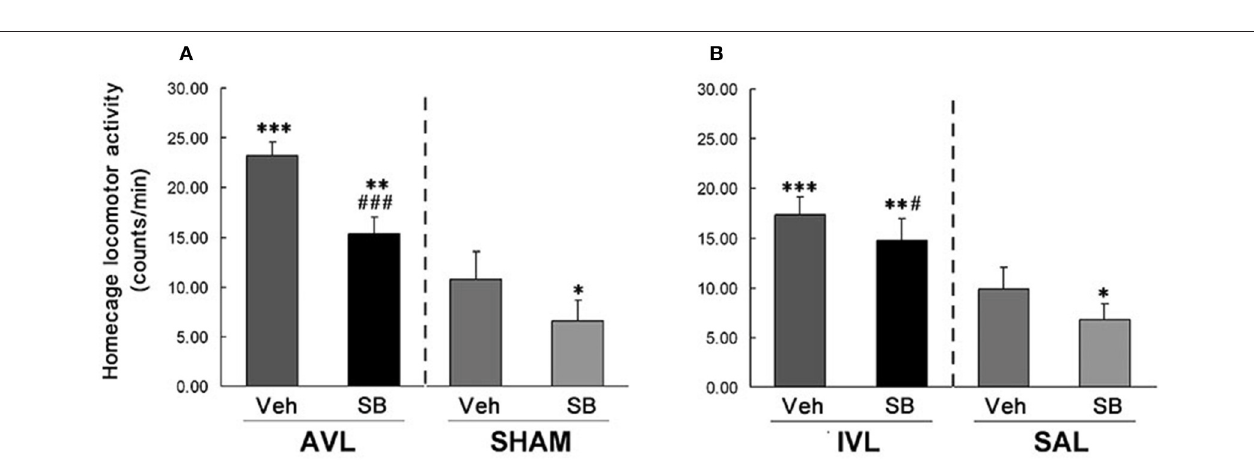
FIGURE 3 | Effects of the orexin receptor type 1 (OX 1 R) antagonist SB334867 on locomotor activity in the home cages after vestibular lesions induced by arsanilate (A) and IDPN (B) in rats. AVL, arsanilate - induced vestibular lesion; SHAM, sham control; IVL, IDPN - induced vestibular lesion; SAL, saline control; Veh, vehicle solution; SB, SB334867. Data are represented as mean ± SEM. * P < 0.05, ** P < 0.01, *** P < 0.001 compared with SHAM or SAL, vehicle control group; # P < 0.05, ### P < 0.001 compared with AVL or IVL vehicle control